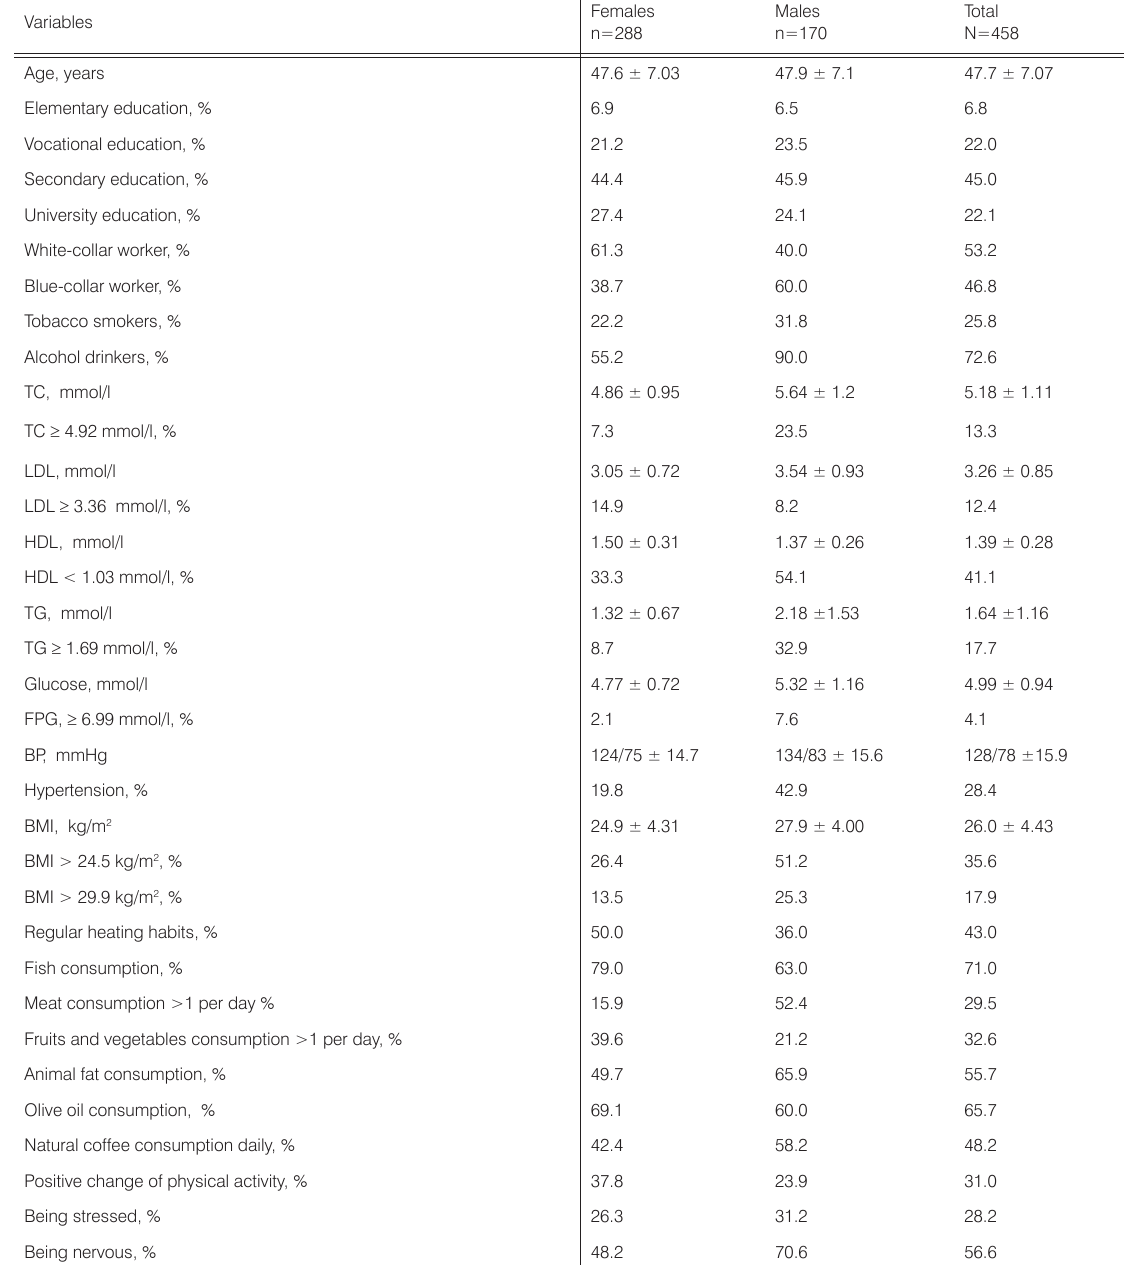
Table 1. Characteristics of the study group